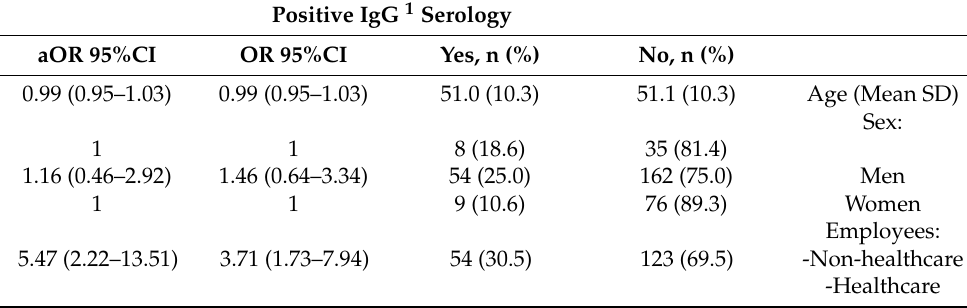
Table 5. Relationship between positive IgG serology and the professional